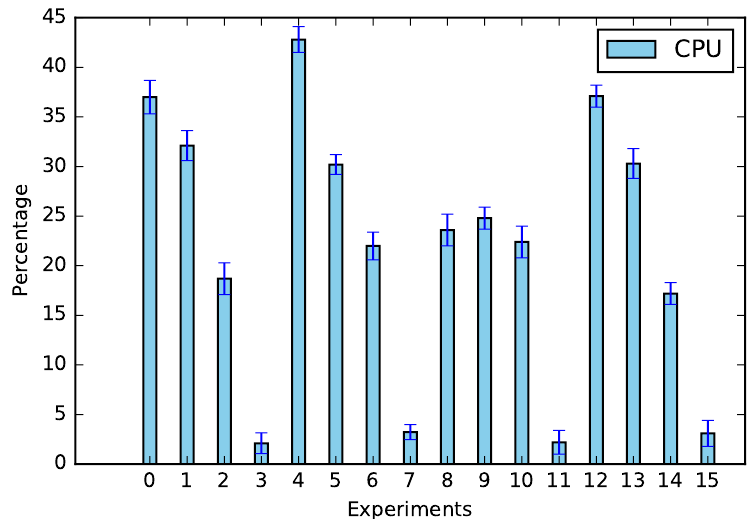
Figure 3. CPU usage. The experiments can be seen in Table 5.